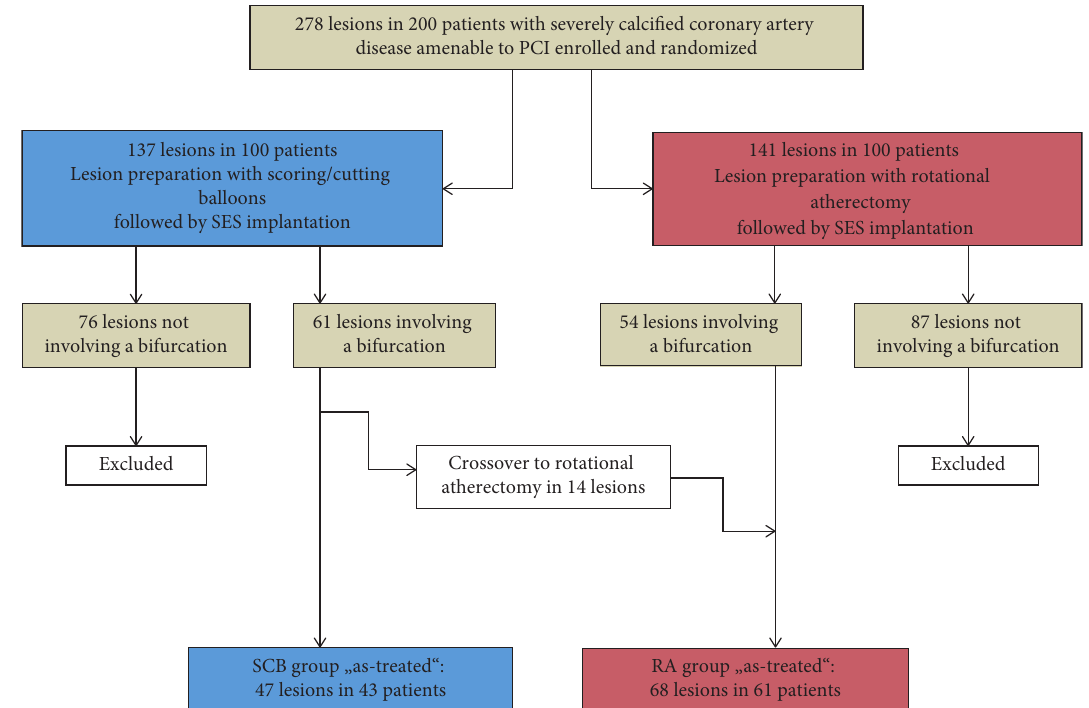
Figure 1: The study flowchart. SCB � scoring/cutting balloons; PCI � percutaneous coronary intervention; RA � rotational atherectomy. Table 1: Baseline characteristics ( n � 104